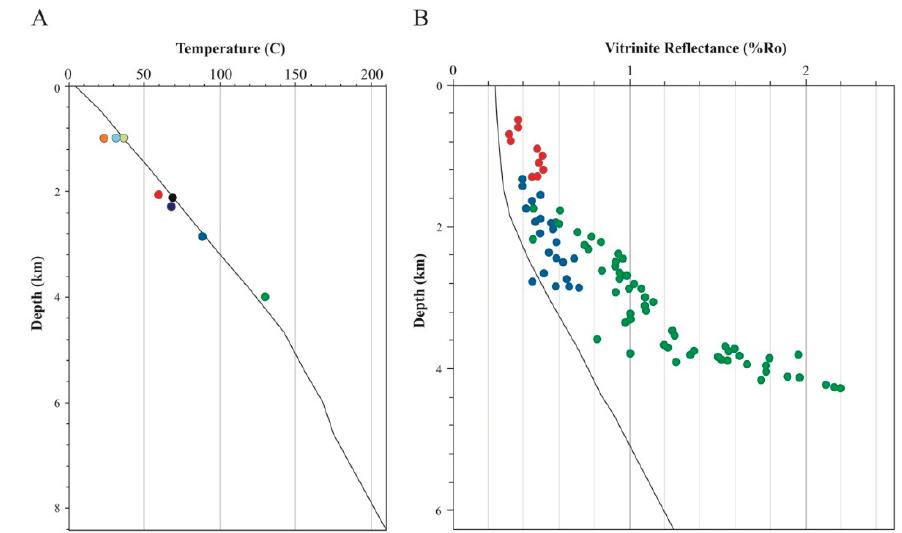
Figure 6. ( A ) Bottom hole temperature measurements of wells 7228 / 7-1B (black), 7227 / 11-U-02 (orange), 7227 / 07-U-01 (light blue), 7230 / 08-U-01 (light green), 7228 / 7-1S (red), 7228 / 2-1S (purple), 7228 / 7-1A (dark blue), and 7228 / 2-1S (dark green). Line shows the modeled, present temperature versus depth trend. ( B ) Vitrinite reflectance data from wells 7228 / 7-1S (red), 7228 / 7-1A (blue), and 7228 / 2-1S (green). Line shows the modeled vitrinite reflectance. Figure 1B shows the location of the wells.